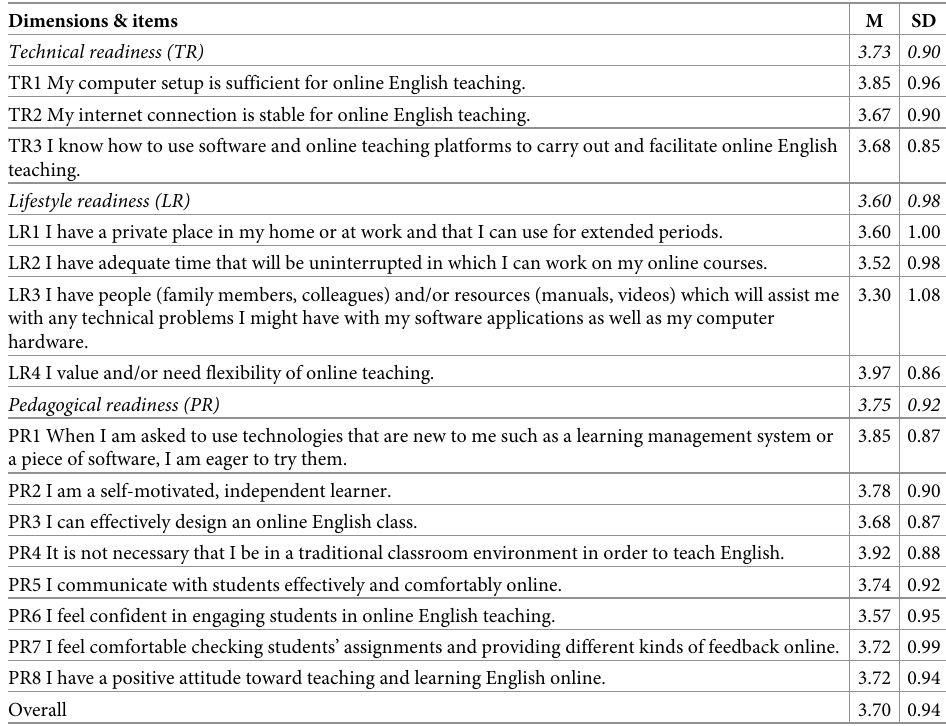
Table 5. Means (M) and standard deviations (SD) of the TRS (N = 149). Dimensions & items M SD Technical readiness